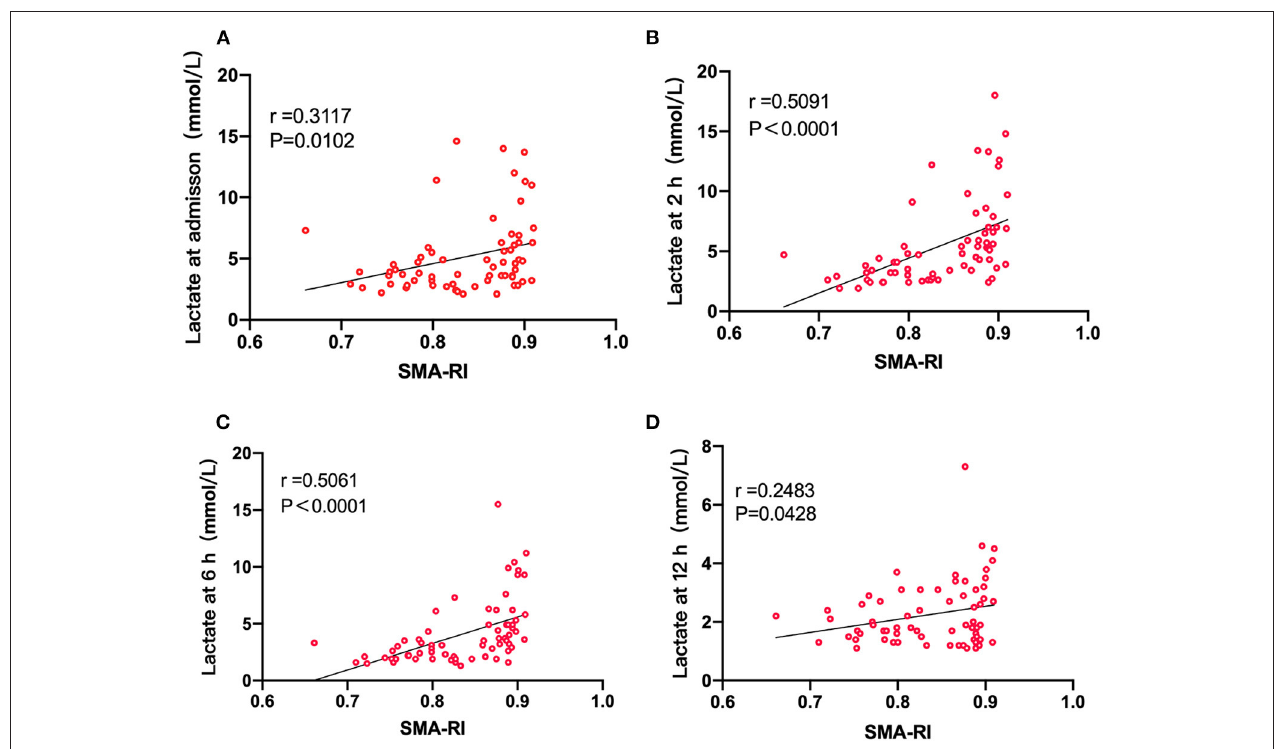
FIGURE 2 | (A) The correlation between SMA-RI and the lactate concentration at admission ( r = 0.3117, P = 0.0102). (B) The correlation between SMA-RI and the 2-h lactate concentration ( r = 0.5091, P < 0.0001). (C) The correlation between SMA-RI and the 2-h lactate concentration ( r = 0.5061, P < 0.0001). (D) The correlation between SMA-RI and the 12-h lactate concentration ( r = 0.2483, P = 0.0428).